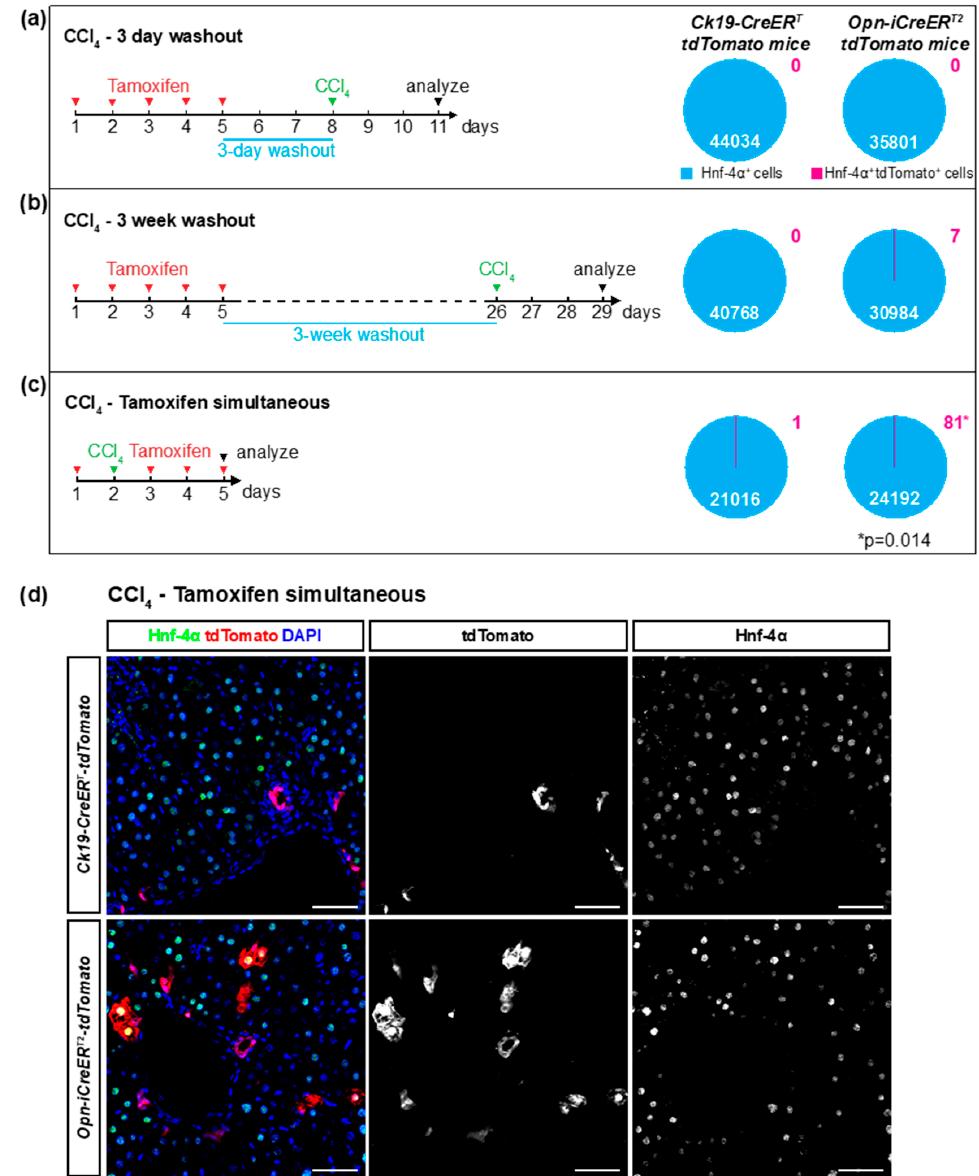
Figure 3. Ectopic activation of Cre drivers in hepatocytes after liver injury. ( a – c ) Schematic experimental outline. Mice were injected with CCl 4 after a three-day washout ( a ), a three-week washout ( b ) or no washout ( c ) after tamoxifen and sacrificed three days later. The percentage of tdTomato + Hnf-4 α + cells was quantified in liver sections of Ck19-CreER-tdTomato and Opn-CreER-tdTomato mice ( n = 3–5; 18 pictures per mouse). ( d ) Immunofluorescent detection of Hnf-4 α and tdTomato on liver sections of mice treated with tamoxifen and CCl 4 without washout period. Scale bars: 50 μ m.